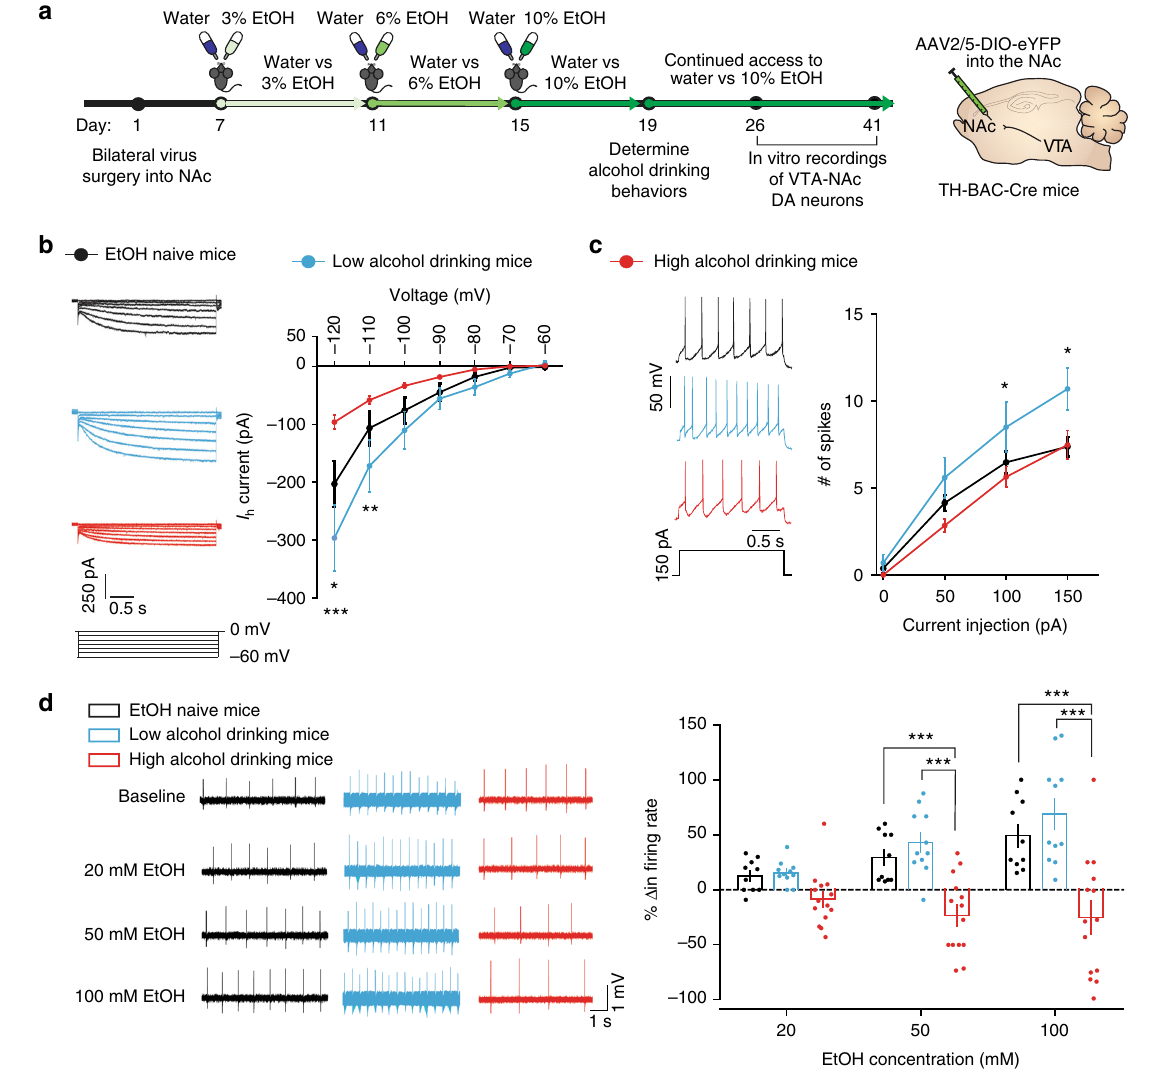
Fig. 6 VTA-NAc neurons of alcohol drinking mice have different intrinsic properties and distinct responses to EtOH. a Timeline of experiments and schematic of surgery. b Representative I h traces (left) and I – V graph of I h (right). (two-way RM ANOVA: drinking group effect F (2, 306) = 4.442, P < 0.05; interaction effect F (12, 306) = 5.421, P < 0.0001. Bonferroni post hoc test * P < 0.05; ** P < 0.01; *** P < 0.001. n = 23 cells from 7 mice; n = 10 cells from 5 mice; n = 21 cells from 6 mice). c Representative spike traces after current injection (left, 150 pA) and excitability data of VTA-NAc neurons from EtOH naive, low alcohol drinking, and high alcohol drinking mice (two-way RM ANOVA: drinking group effect F (2, 159) = 4.551, P < 0.05; interaction effect F = 1.839, P = 0.0948. Bonferroni post hoc test * P < 0.05. n = 21 cells from 5 mice; n = 10 cells from 3 mice; n = 25 cells from 5 mice). Data (6, 159) represented as mean + S.E.M. d Representative spontaneous fi ring rate traces during different bath applications of EtOH (left) and % change ( Δ ) in fi ring rate from baseline (responsivity) during bath application of 20, 50, and 100 mM EtOH in aCSF (right) (two-way RM ANOVA: drinking group effect F = 15.18, P < 0.0001; EtOH concentration effect F = 12.67, P < 0.0001; interaction effect F = 10.30, P < 0.0001. Bonferroni post hoc (2, 64) (2, 64) (4, 64)